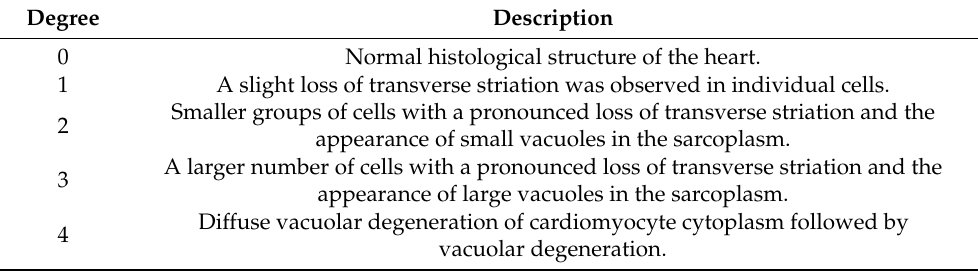
Table 2. Tissue damage score for the heart alterations (CDS—Cardiomyocyte Damage